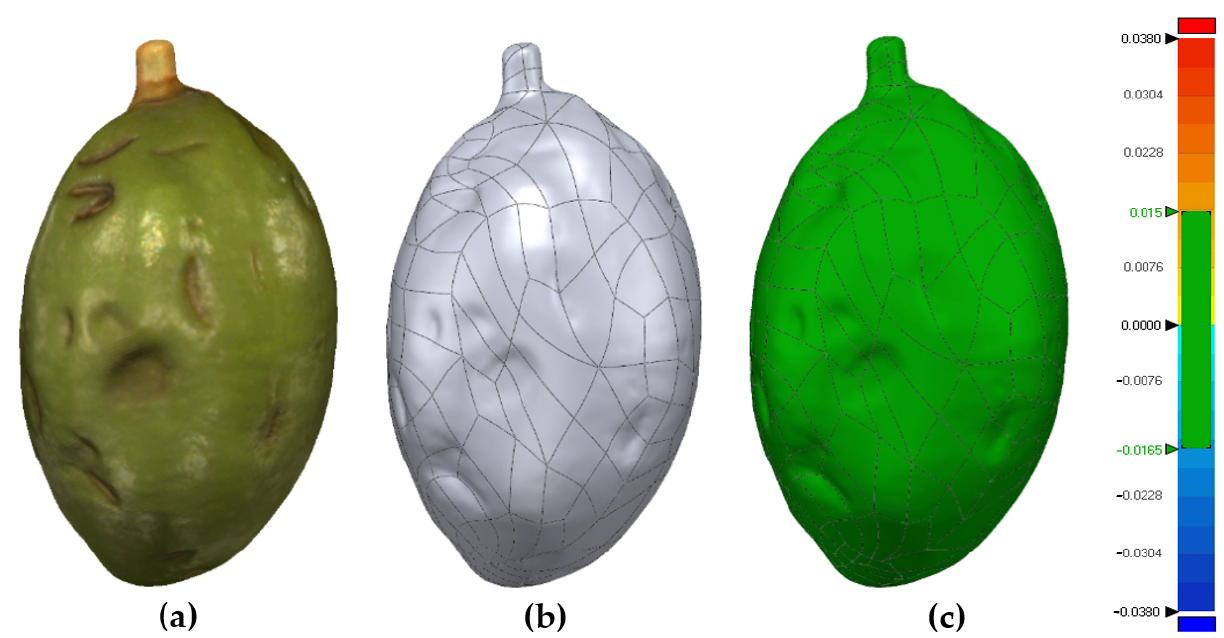
Figure 7. NURBS model of real olive: ( a ) 3D mesh texturing; ( b ) NURBS surfaces, and ( c ) surfaces deviation.